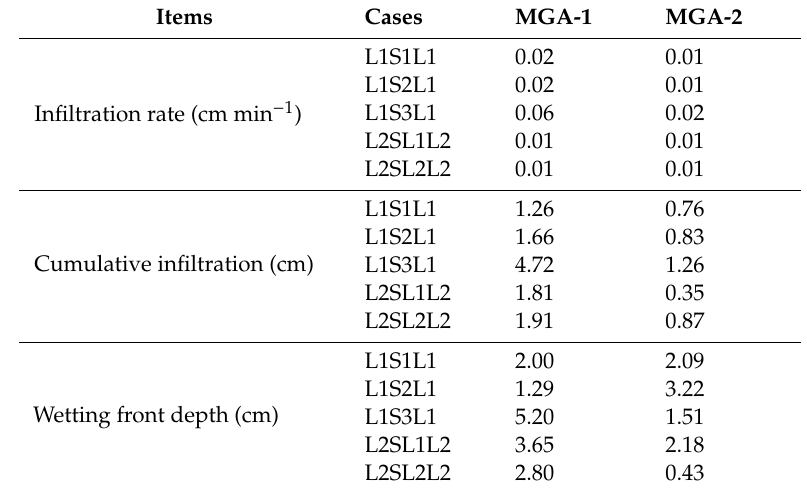
Table 6. The root mean square error (RMSE) values for the simulation results of the MGA-1 and MGA-2.